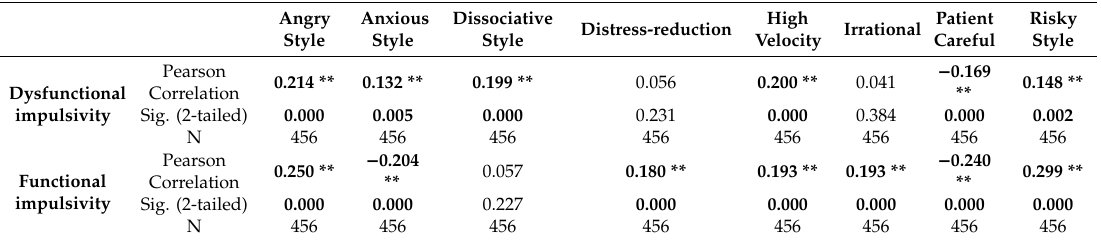
Table 3. Correlations between the driving styles and the functional and the dysfunctional